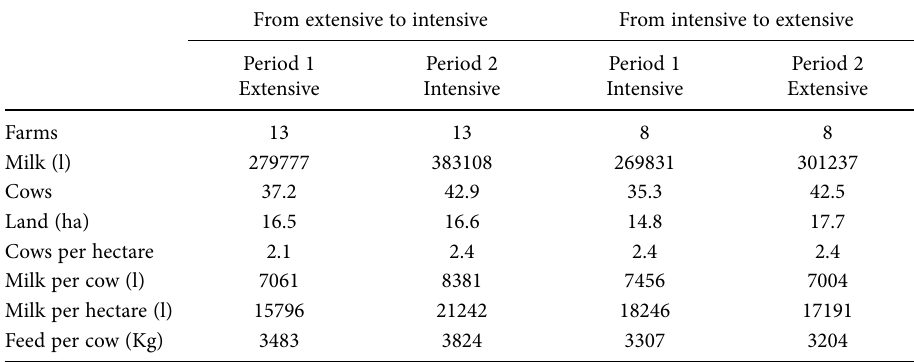
Table 6. Characteristics of the farms that switch production system over